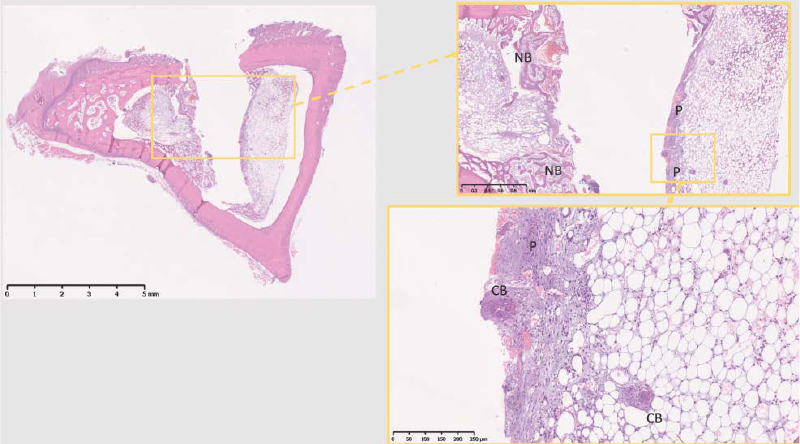
Figure 6. The 10 days Cu site. No bone on the immediate implant vicinity. FBGC, foreign body giant cells; Oc, osteoclast actively remodeling old bone; Ob, Seam of osteoblasts producing new bone (part of the remodeling); IO, Implant/Osteotomy. Reaction to Cu divided in 3 zones, representing the 3 phenomena around implant materials in the bone: From the implant surface Lytic/Inflammatory area, Fibroproliferative area and Osteoproliferative area. The latter two represent an attempt to isolate the material from the marrow cavity. No osseointegration is viable at this time point. Theoretically, around Ti the same phenomena exist, but at a different balance, allowing for osseointegration, through direct bon-to-implant contact. Inflammatory area is highly vascularized. Scale bars 5 mm (left) and 100 µm (right).